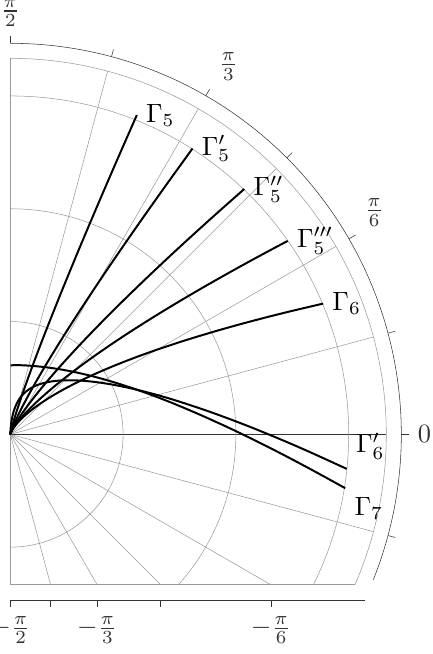
( 1,2 ] and with different values of the parameter θ . The contours ∈ 0.6, Γ (cid:48) - θ = 0.4, Γ (cid:48)(cid:48) - θ = 0.2, Γ (cid:48)(cid:48)(cid:48) - θ = 0, Γ 6 - θ = 0.2, 5 5 5 − − −